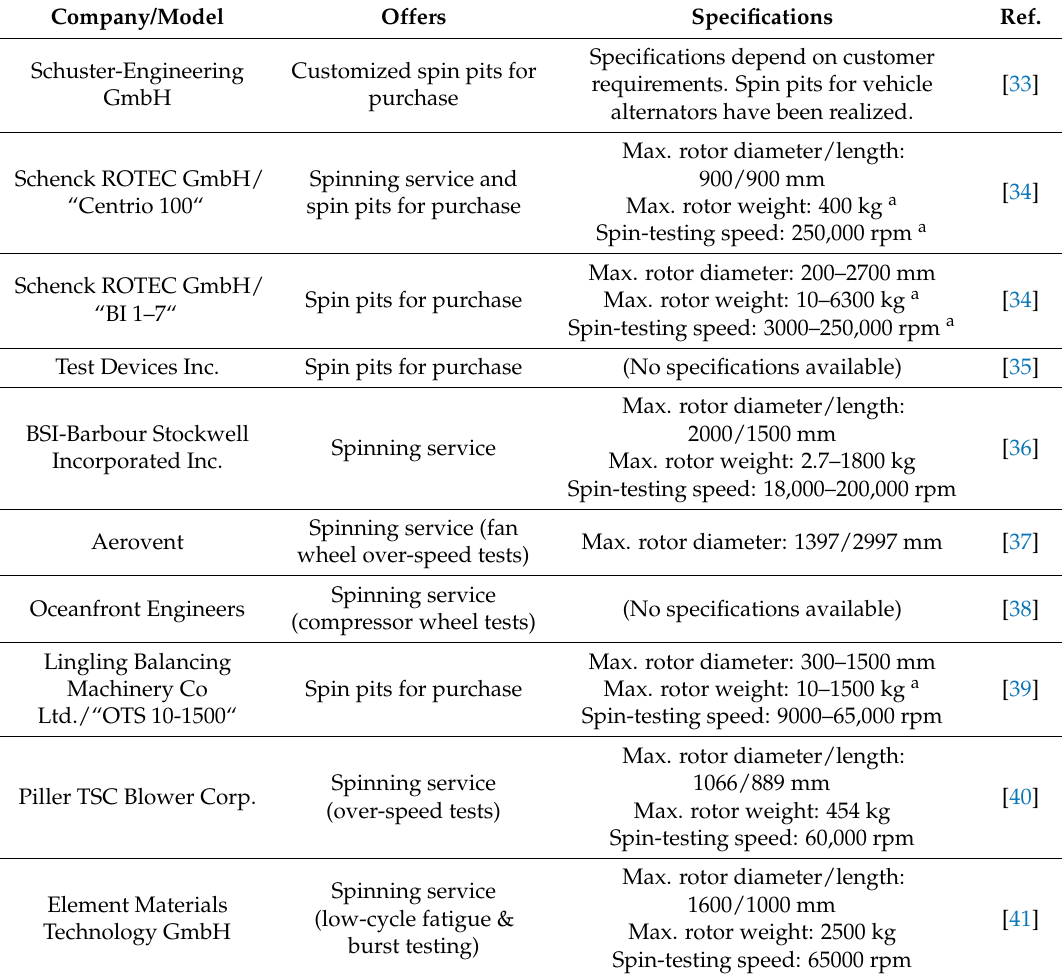
Table 2. Commercially available spin rigs and spin testing services. Company/Model